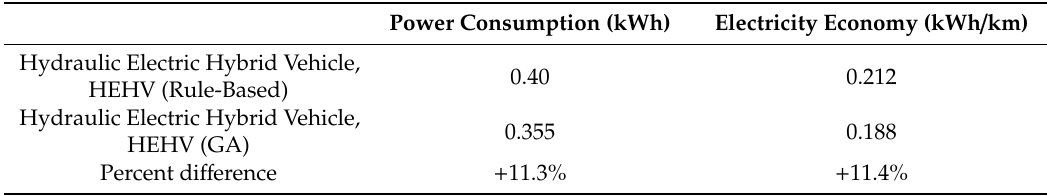
Table 4. Comparison between electricity economic performances.